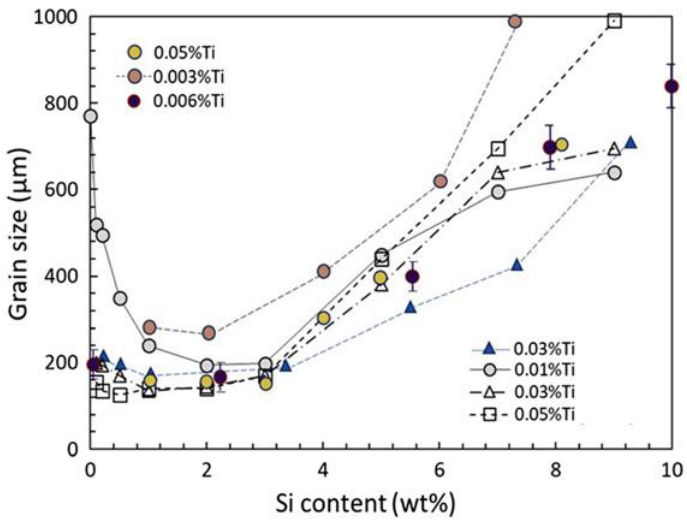
Figure 16. Grain size of binary Al-Si alloys (inoculated by Al-Ti-B grain refiner) as a function of Si concentration (the data were collected from the literature and plotted in Ref. [30]). The representative data collected from the literature showing the variation of the grain size with Si content of binary Al-Si alloys inoculated with Al-5Ti-1B grain